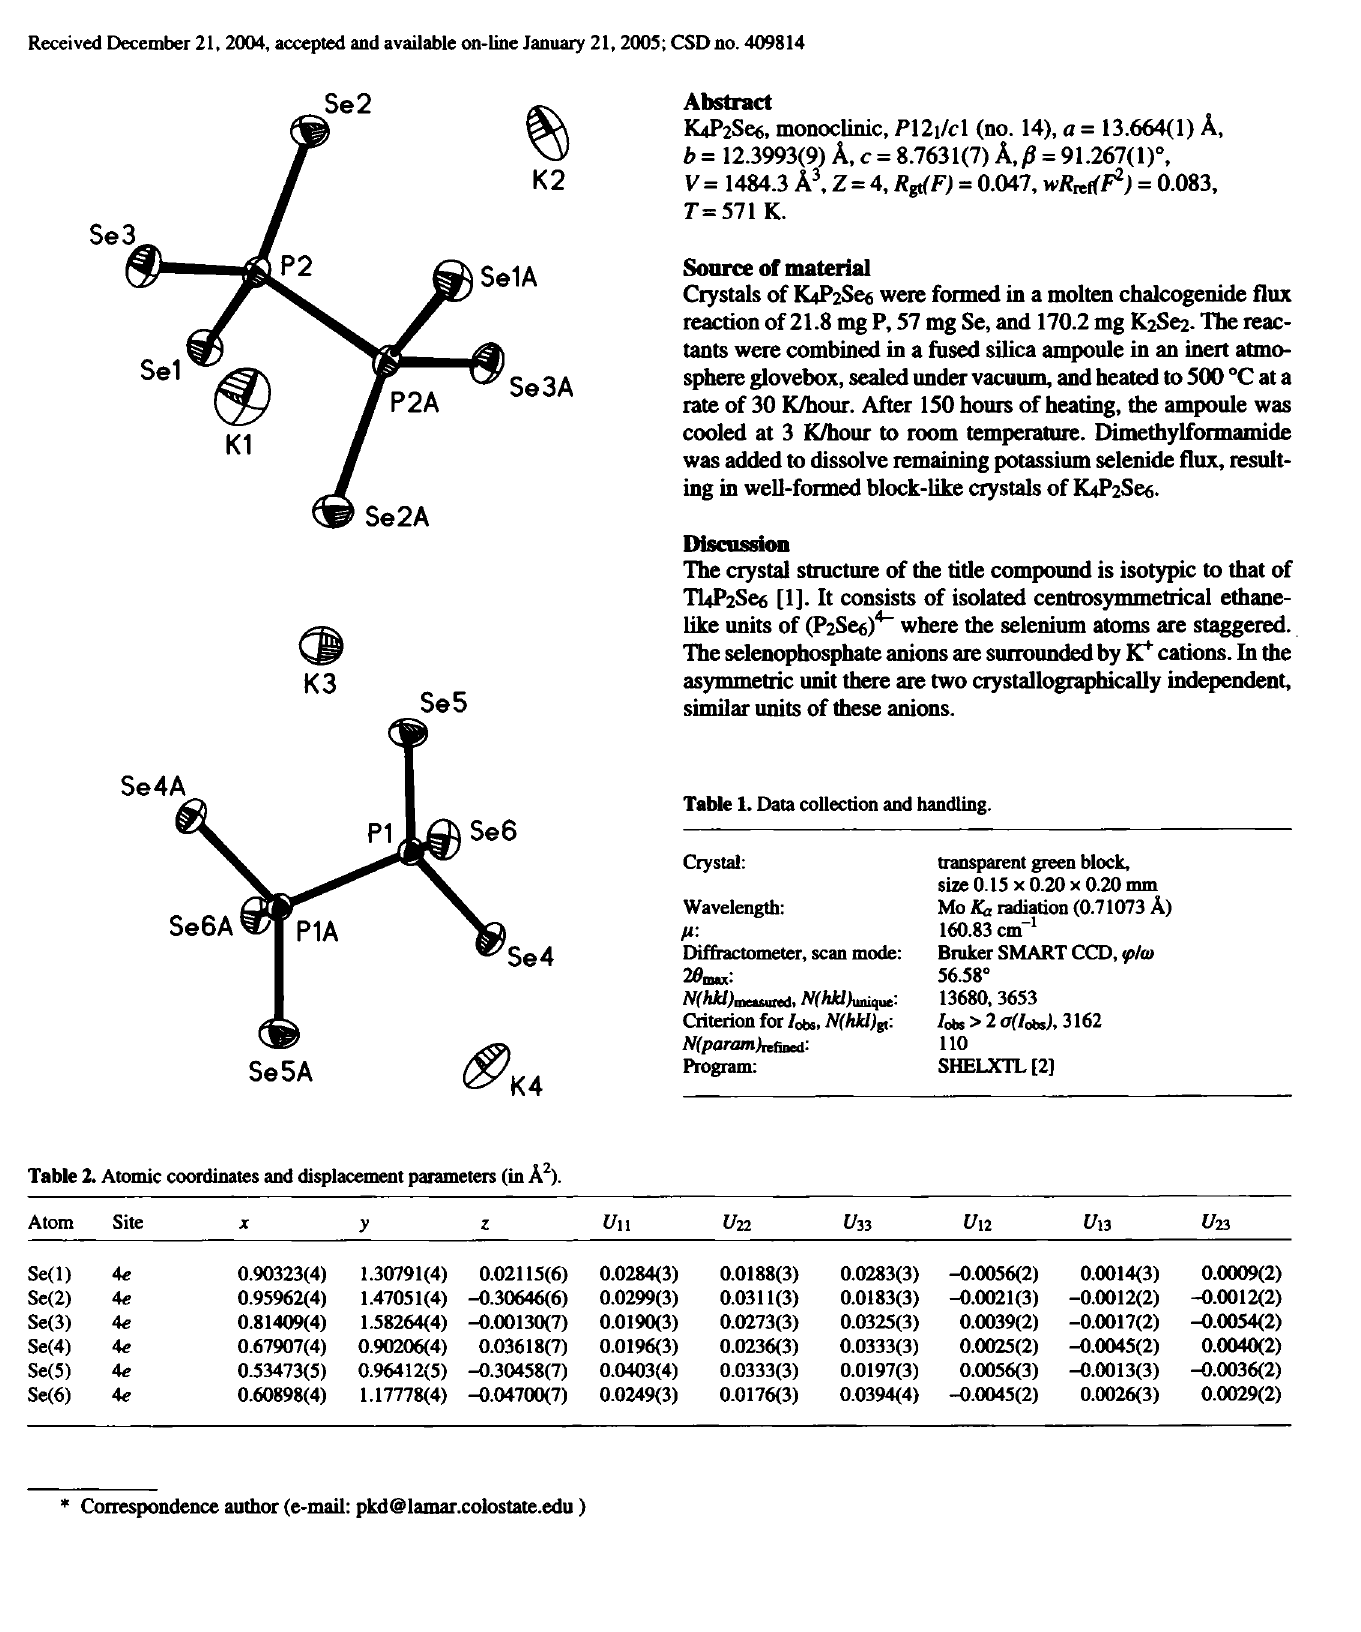
Table 1. Data collection and handling.